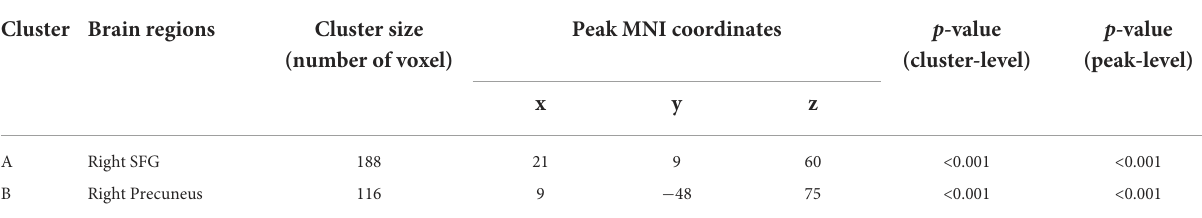
TABLE 3 Clusters with significant group differences in RSFC